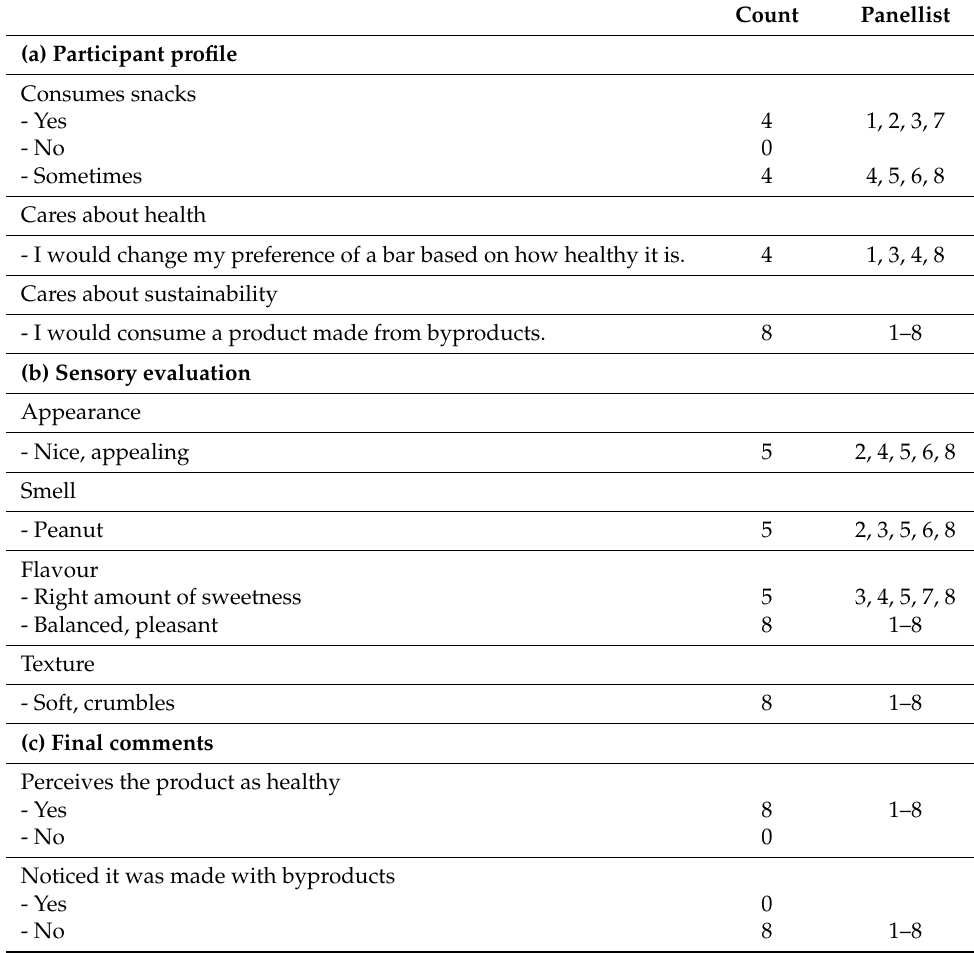
Table 3. Overview of the opinions of the participants in the focus group.